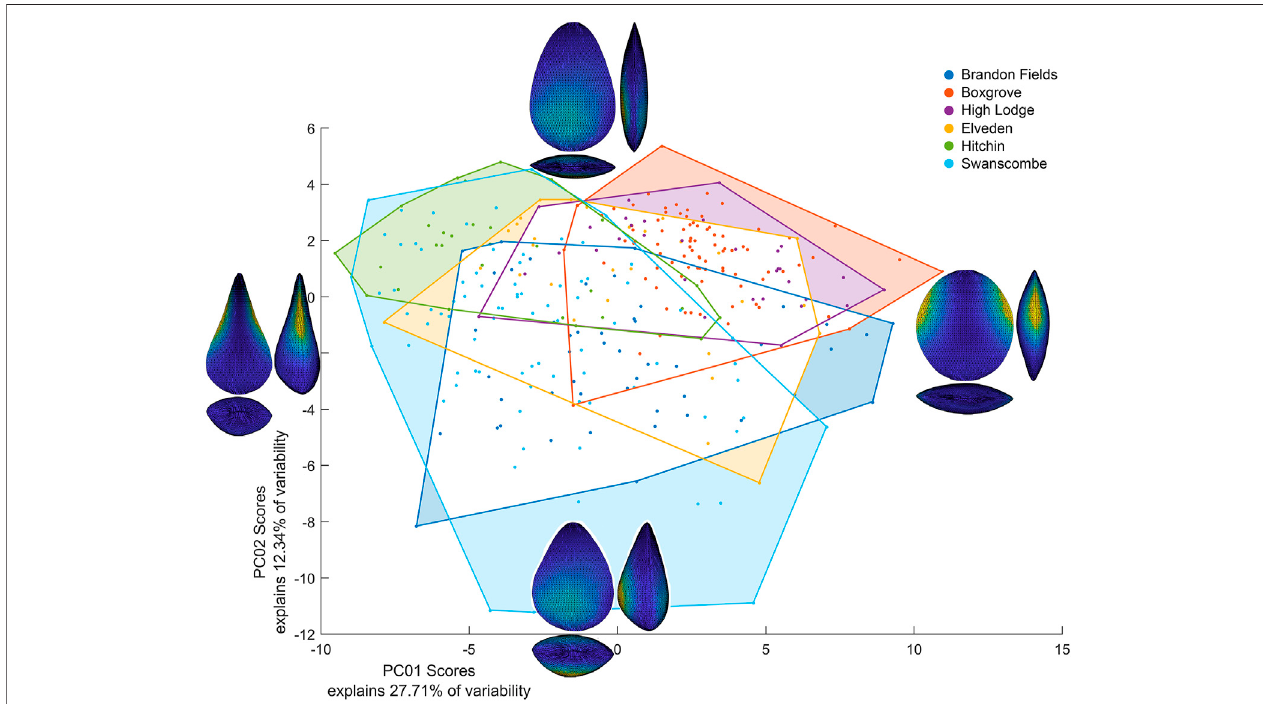
FIGURE 2 | Geometric morphometrics: PCA on handaxe 3D models by sites. Illustrations show hypothetical objects situated at the extremities of each principal component, re fl ecting the shape trend it represents. Convex hulls represents the scatter plot limits on each site. The white area is the overlapped area.